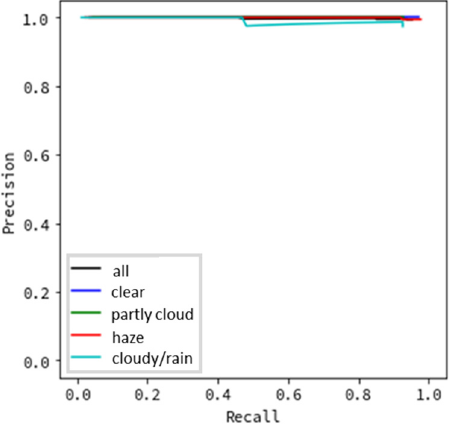
Figure 7. Detection precision by type of weather (not including categorization).